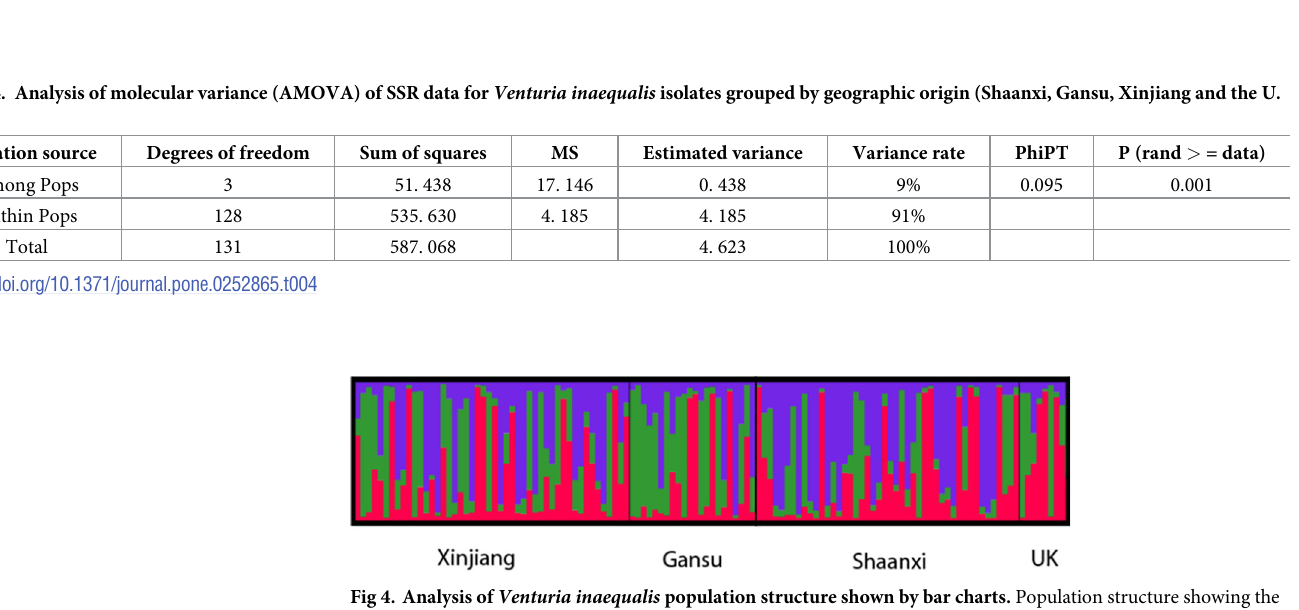
Table 3. The genetic distance and similarity of Venturia inaequalis populations among four different regions. Populations